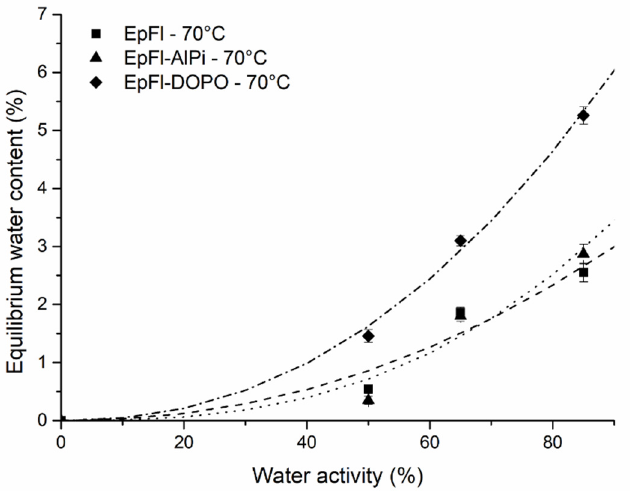
Figure 2. Equilibrium moisture content as a function of water activity at 70 °C.